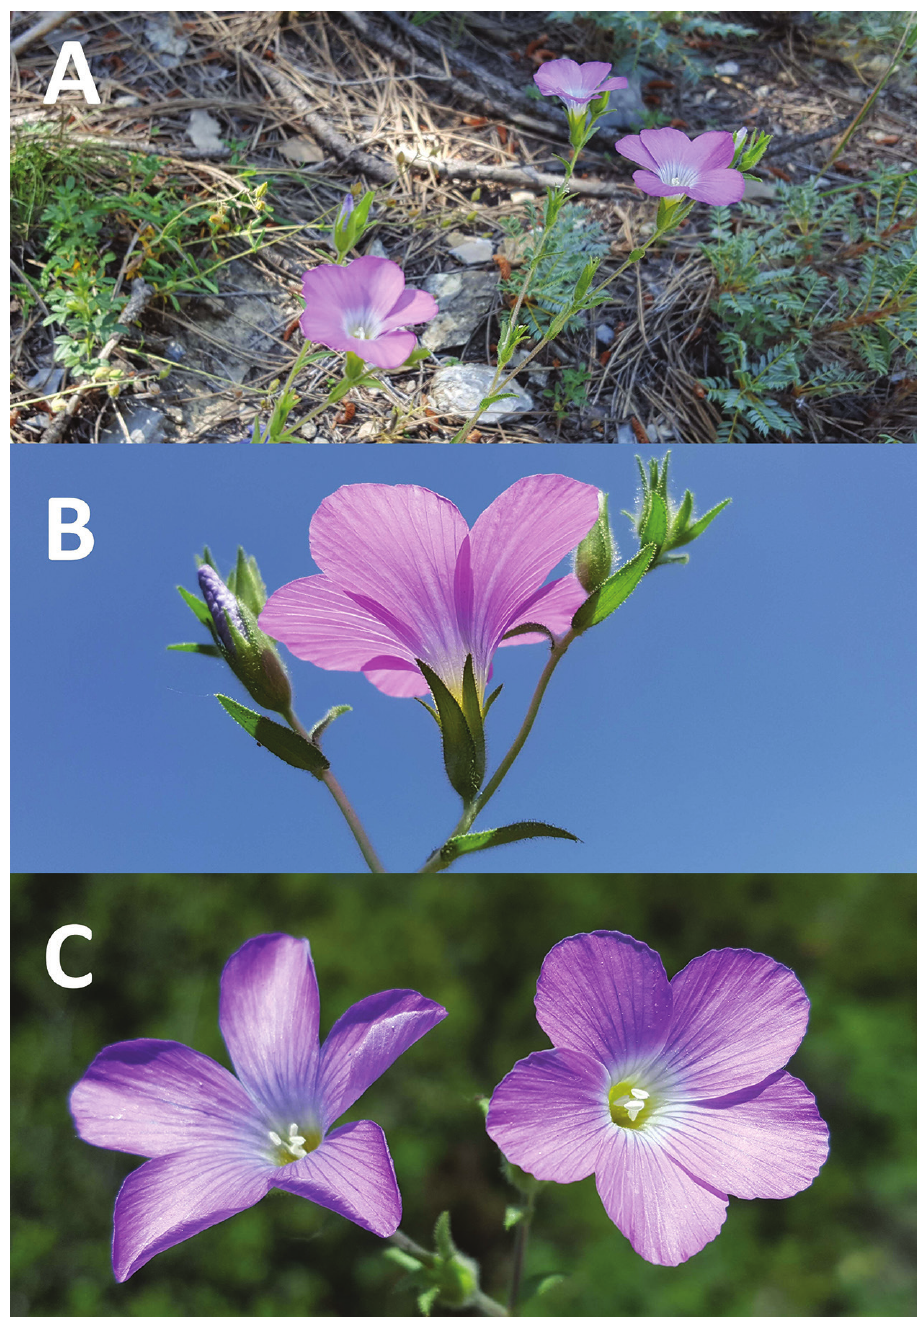
Figure 3. General view of habit and flower A–C Linum aksehirense